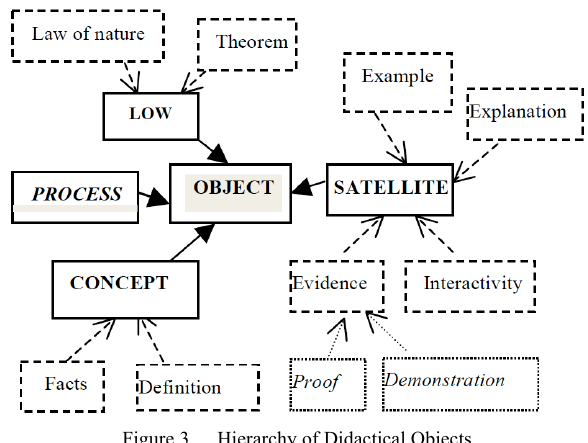
Figure 3. Hierarchy of Didactical